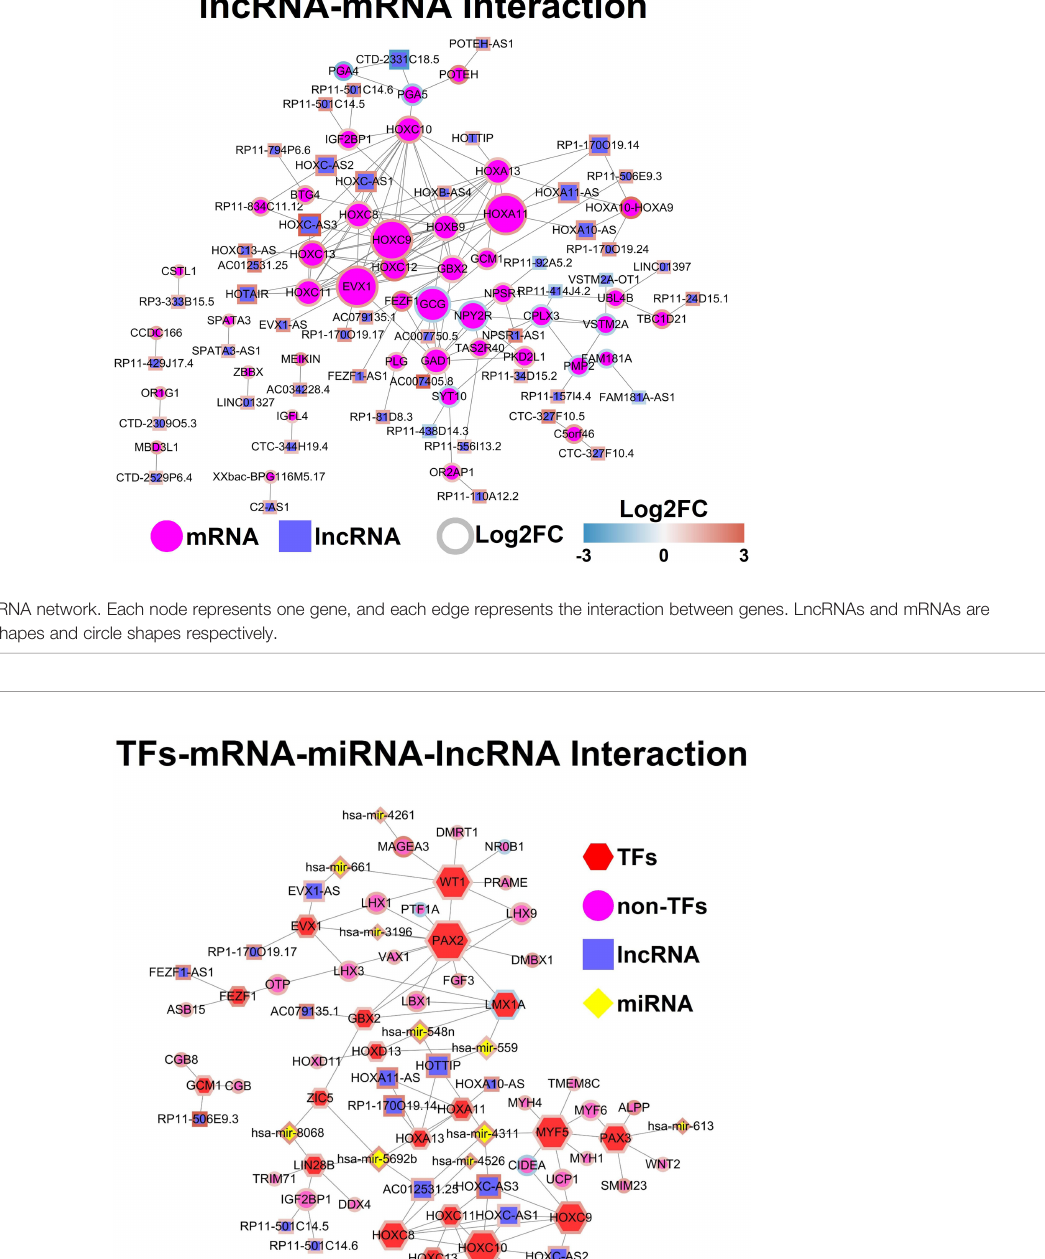
823 and AGS cells by transfecting these cells with HOXC8 siRNAs. HOXC8 siRNAs transfection signi fi cantly down-regulated the